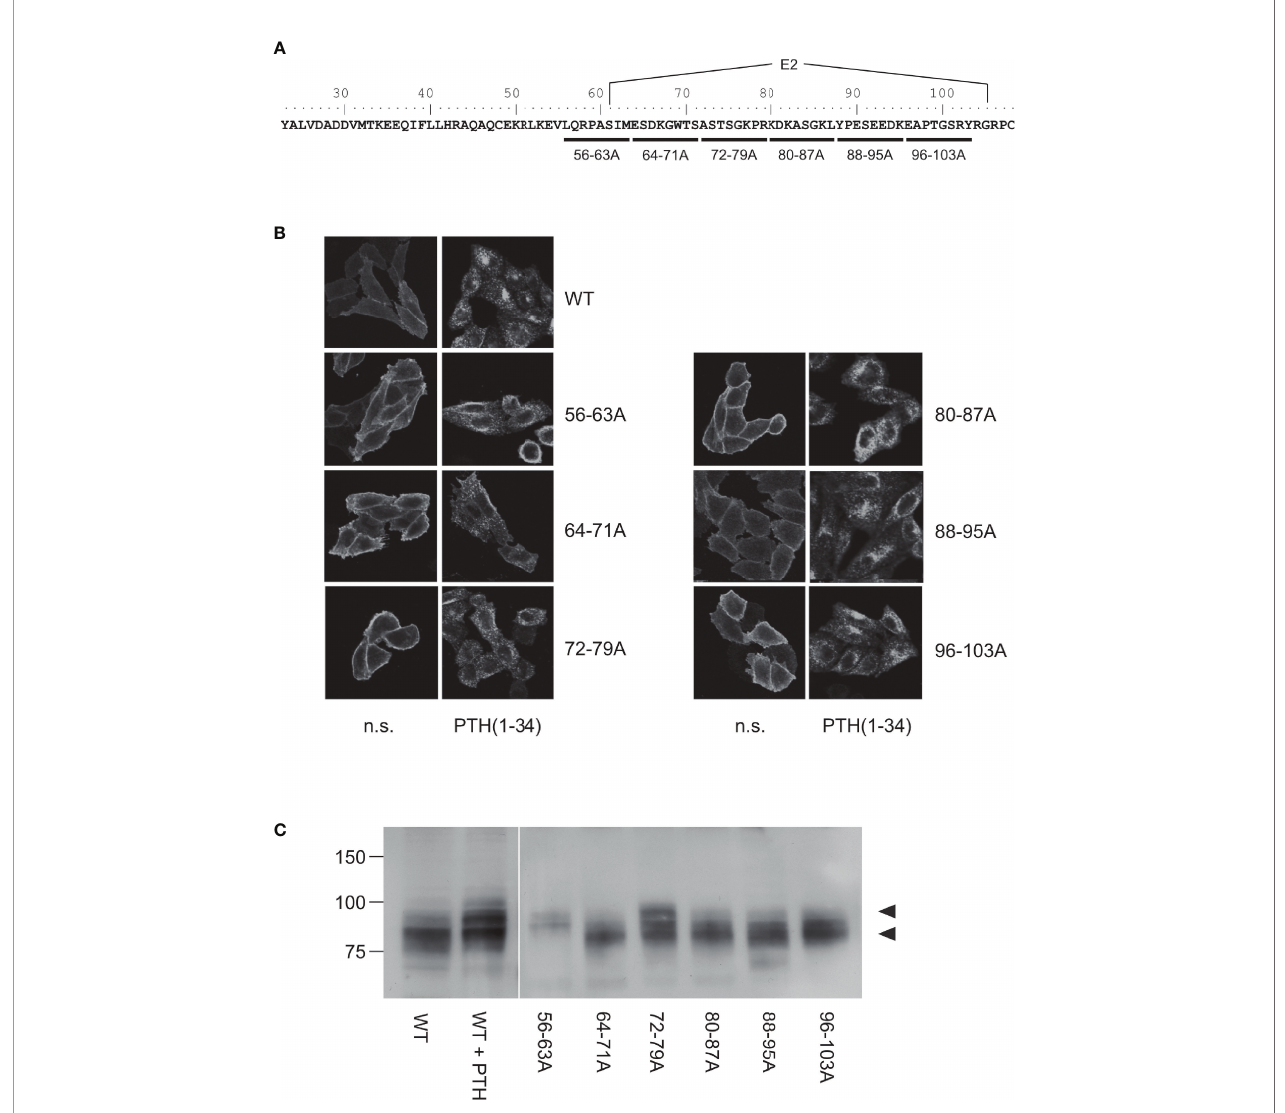
FIGURE 2 | Mapping of the protease cleavage site of PTH1R ECD by alanine scan. (A) Amino acid sequence of the extracellular domain of the human PTH1R. Stretches of 8 amino acids that were replaced by alanine residues are indicated by horizontal bars. Exon E2 is marked above the sequence. (B) CHO cells stably expressing PTHR variants were treated with 100 nM PTH(1-34) for 30 min or left untreated. Subsequently, cells were fi xed, permeabilized, and stained with rabbit anti-PTH1R antibody followed by Cy2-labeled anti-rabbit antibody. PTHR was visualized by confocal microscopy. (C) CHO cells stably expressing PTHR variants were lysed, and PTH1R was monitored by reducing SDS-PAGE and Western blotting. Cells were treated with 100 nM PTH(1-34) for 12 h prior to cell lysis where indicated. Arrowheads depict the cleaved (MW ~80 kDa) and the uncleaved (MW ~90 kDa) PTH1R band. n.s., not